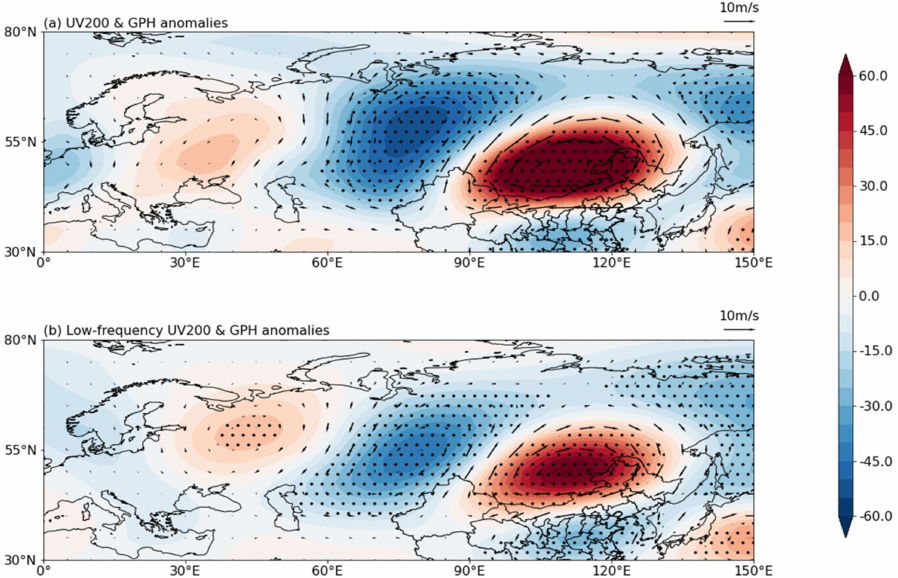
Figure 4. Composited geopotential height (GPH) and horizontal winds anomalies ( a ) and their low-frequency component (10–30 d oscillation) ( b ) at 200 hPa of the summer LFEHTs in northeast China from 1981 to 2019. Dotted areas are significant at a 95% confidence